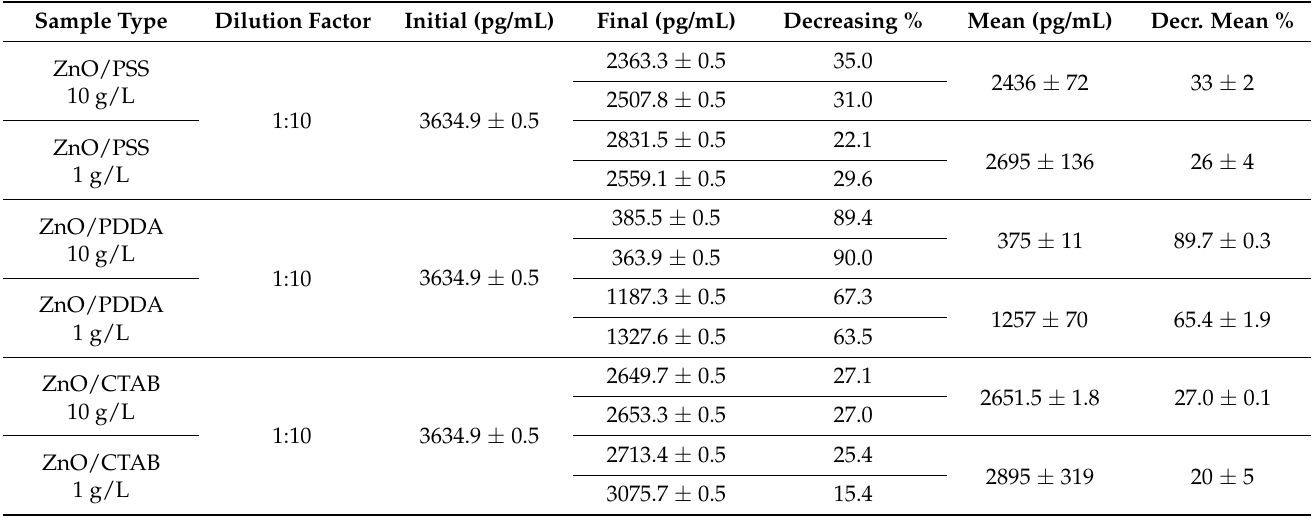
Table 1. Antigen quantification before and after exposure to 10 g/L or 1 g/L